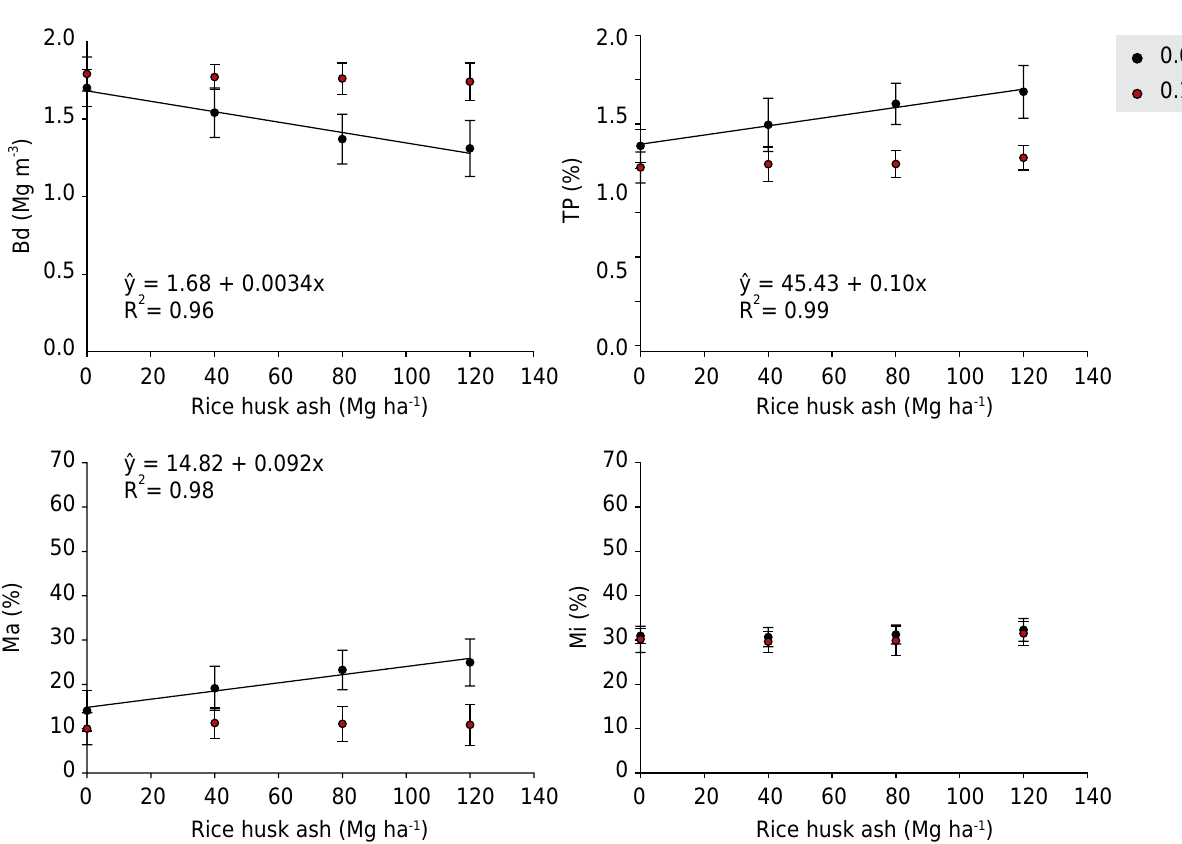
Figure 1. Mean values of (a) soil bulk density (Bd), (b) total porosity (TP), (c) macroporosity (Ma) and (d) microporosity (Mi) of a Typic Hapludult under different rates of rice husk ash in the 0.00-0.10 and 0.10-0.20 m layers. Vertical bars indicate the standard